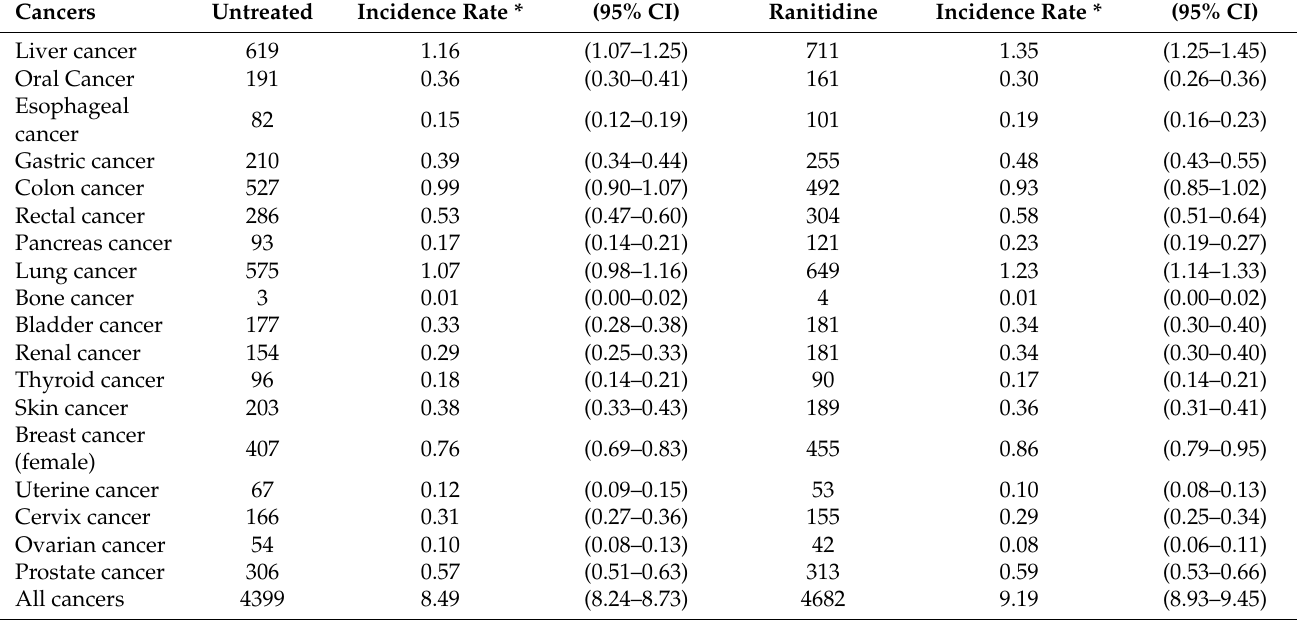
Table 2. Incidence rates of individual cancers (per 1000